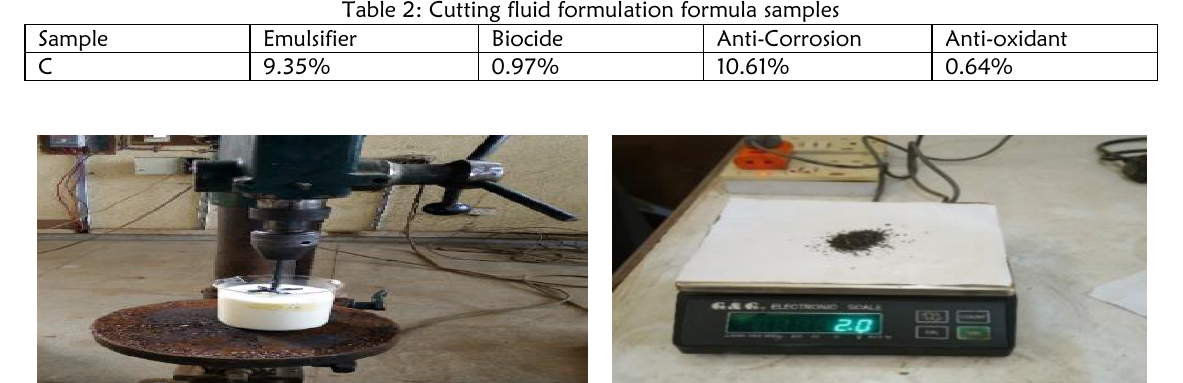
Figure 2: Electronic scale used for measuring cast iron chips for corrosion